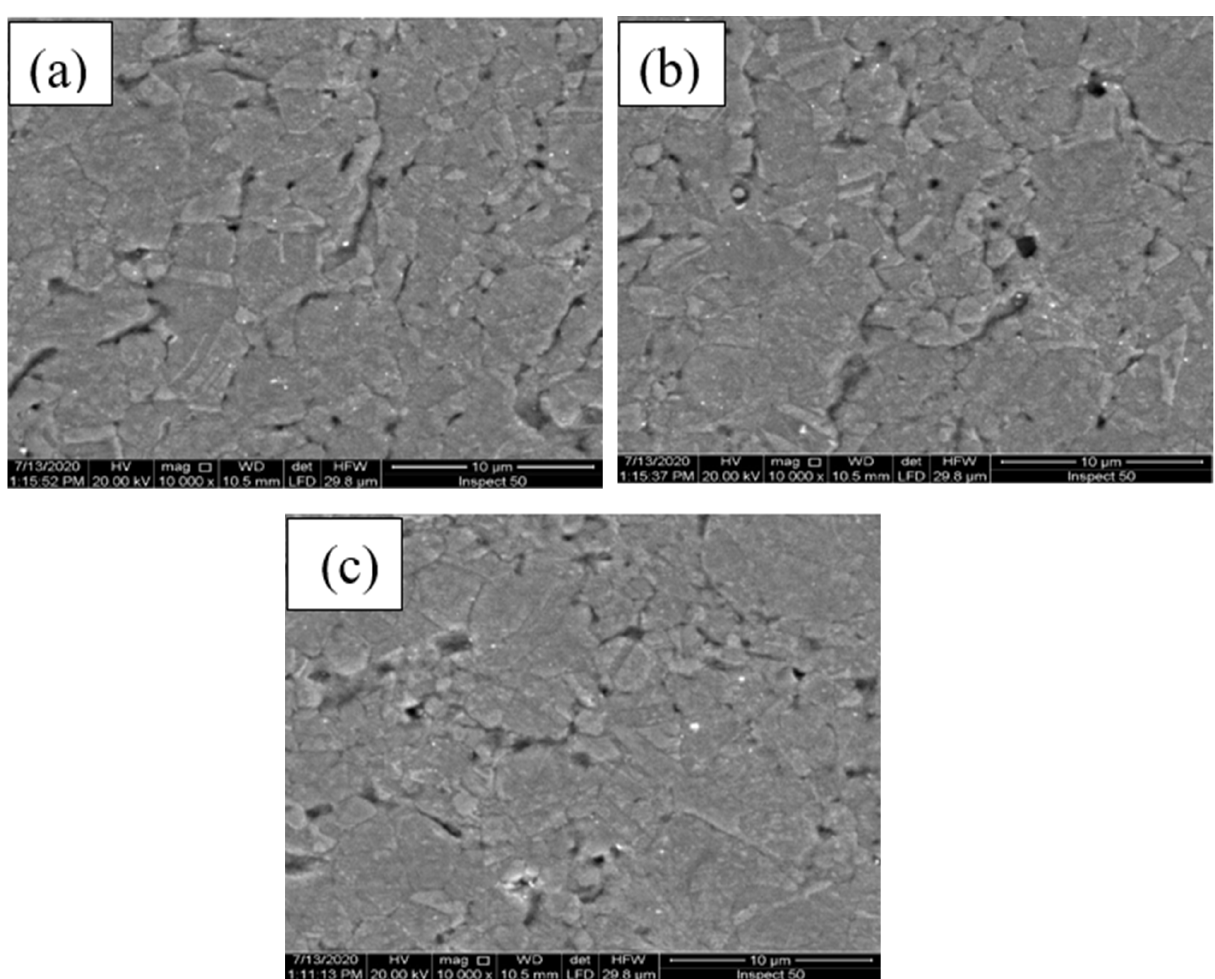
Figure 4. SEM micrograph of ( a ) 0.4, ( b ) 0.8, and ( c ) 1.2 wt.% MWCNT content on Cu nanocomposites.